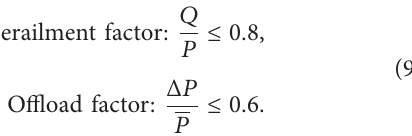
wheel-rail force to the average wheel-rail force wheel set: Δ𝑃/𝑃 . The expressions and allowable values of these indices are given in Chinese codes as